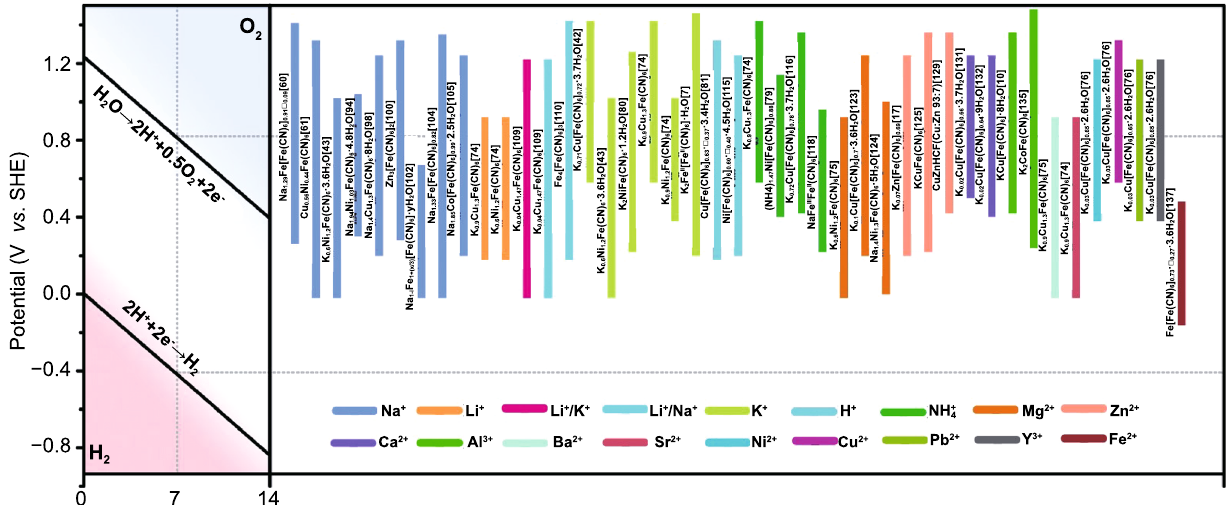
Fig. 12 Voltage working window of PBAs for various aqueous